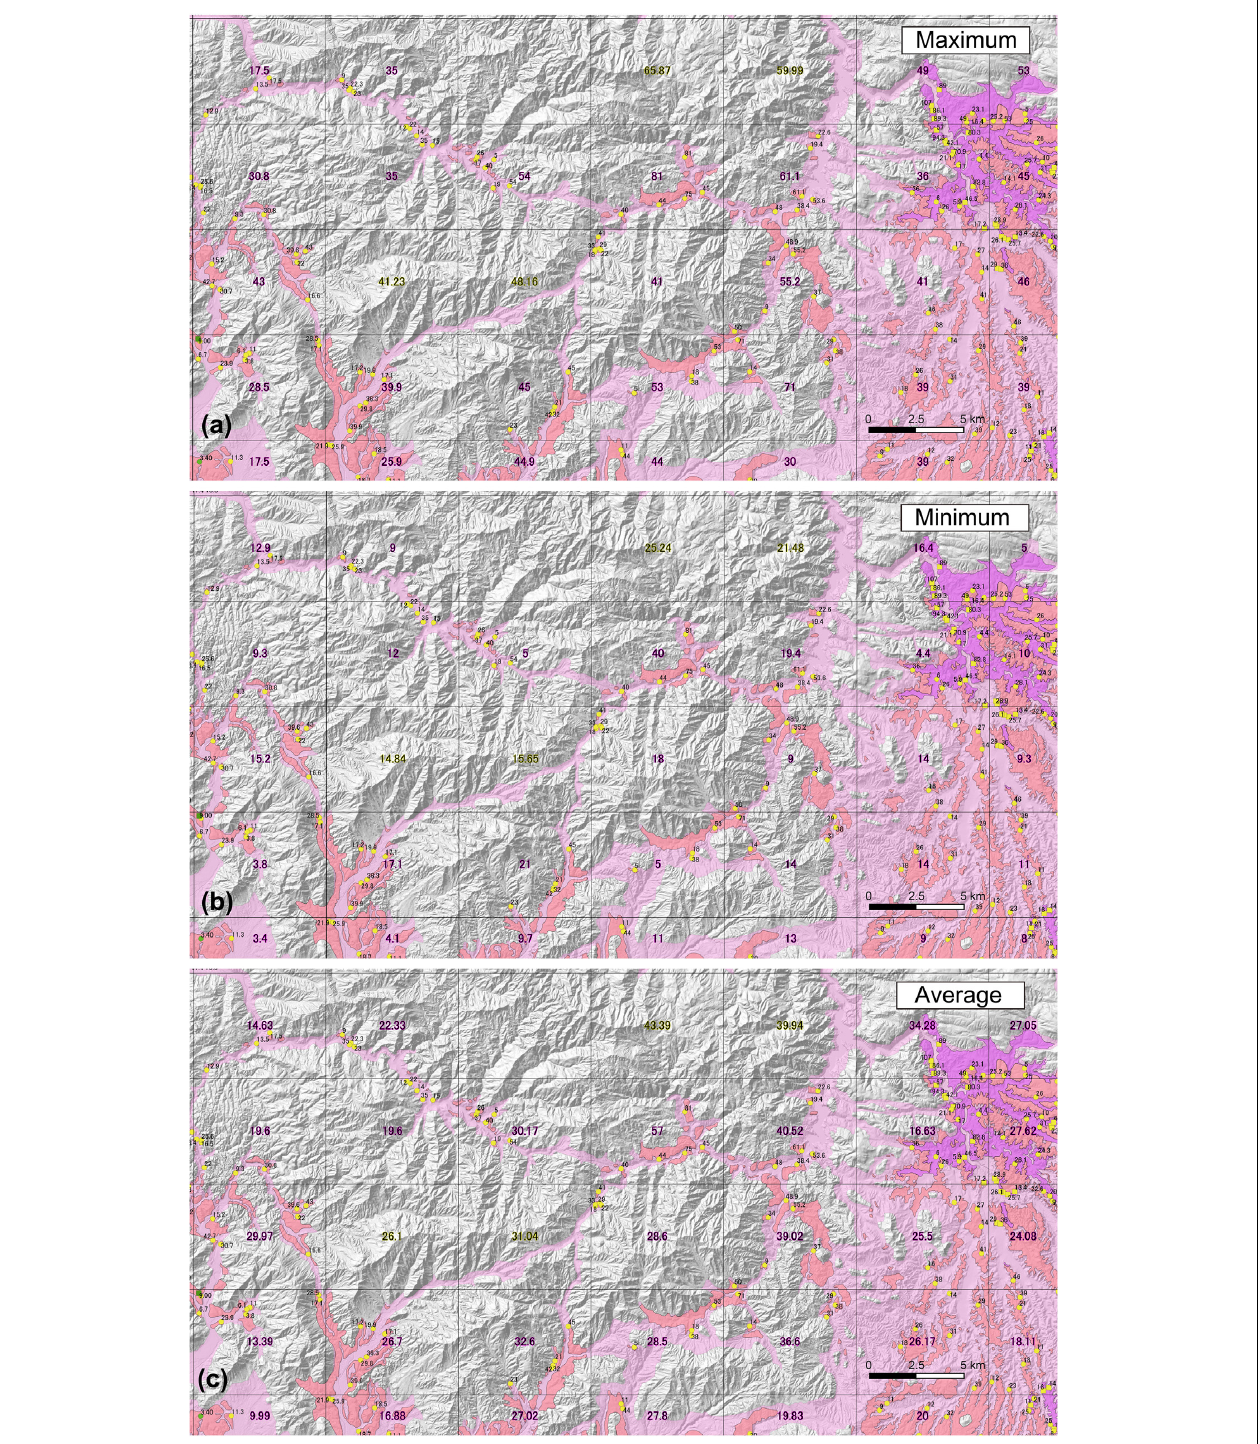
FIGURE 6 | Estimated thickness of non-welded parts of Aso-4 PDC deposits [maximum (a) , minimum (b) , and average (mean) cases (c) ] at NW side of Aso caldera. Orange-colored parts are the non-welded facies of Aso-4 PDC deposits (current exposure). Purple-colored parts are the welded-facies (current exposure). Light pink-colored parts are the estimated original distribution of the Aso-4 PDC deposit. Purple-colored rim numbers are the maximum (a) , minimum (b) , and average (c) thickness values (m) of all points data within the cell. Yellow-colored rim numbers are the estimated thickness values using the ordinary kriging method. Circles and Squares on the map indicate locations to measure the thickness of PDC deposits based on borehole (green) and topography (yellow) sites. The circle marks are non-welded, and the square marks are welded points. The Geospatial Information Authority of Japan (GSI) Tile Map (Shaded relief map) is used as the base map.